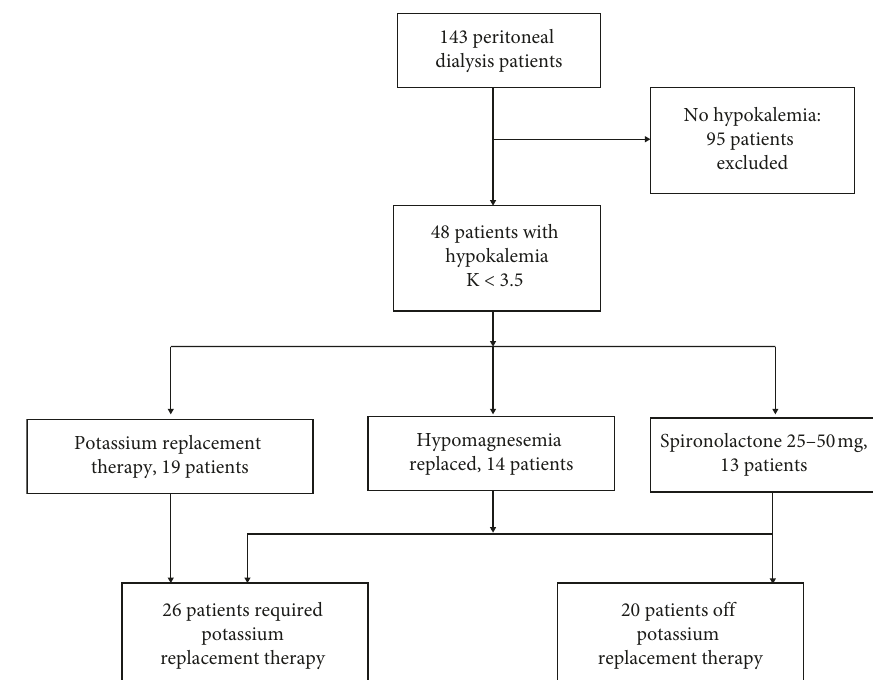
Figure 2: Flowchart of our quality improvement project population and outcome.